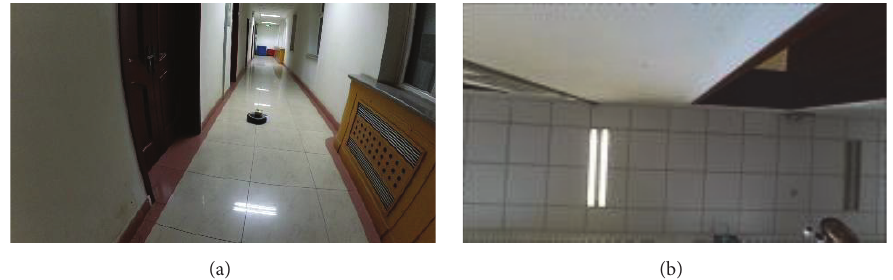
Figure 12: The experiment site. (a) The robot moving in the experiment site. (b) The ceiling in the robot vision.